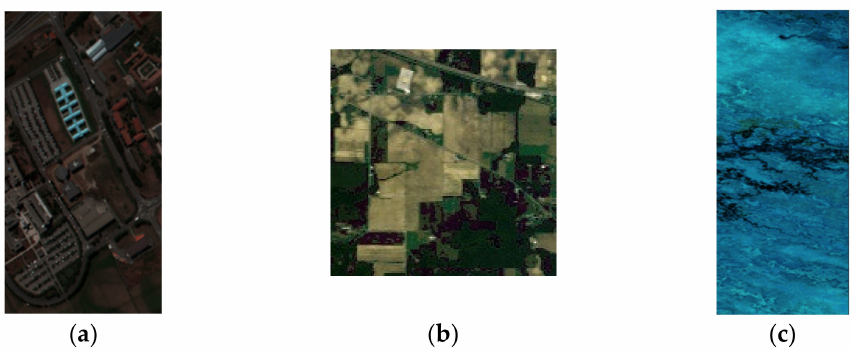
Figure 5. RGB false-color image of HRSIs: ( a ) Pavia University, ( b ) Indian Pines, and ( c ) Botswana. Pavia University HRSI was imaged by a reflective optics system imaging spectrometer (ROSIS) in Pavia City, Italy in 2003. After eliminating the noise and water absorption bands, 103 spectral bands were retained. It has 9 ground objects, with a total data size of 610 ×